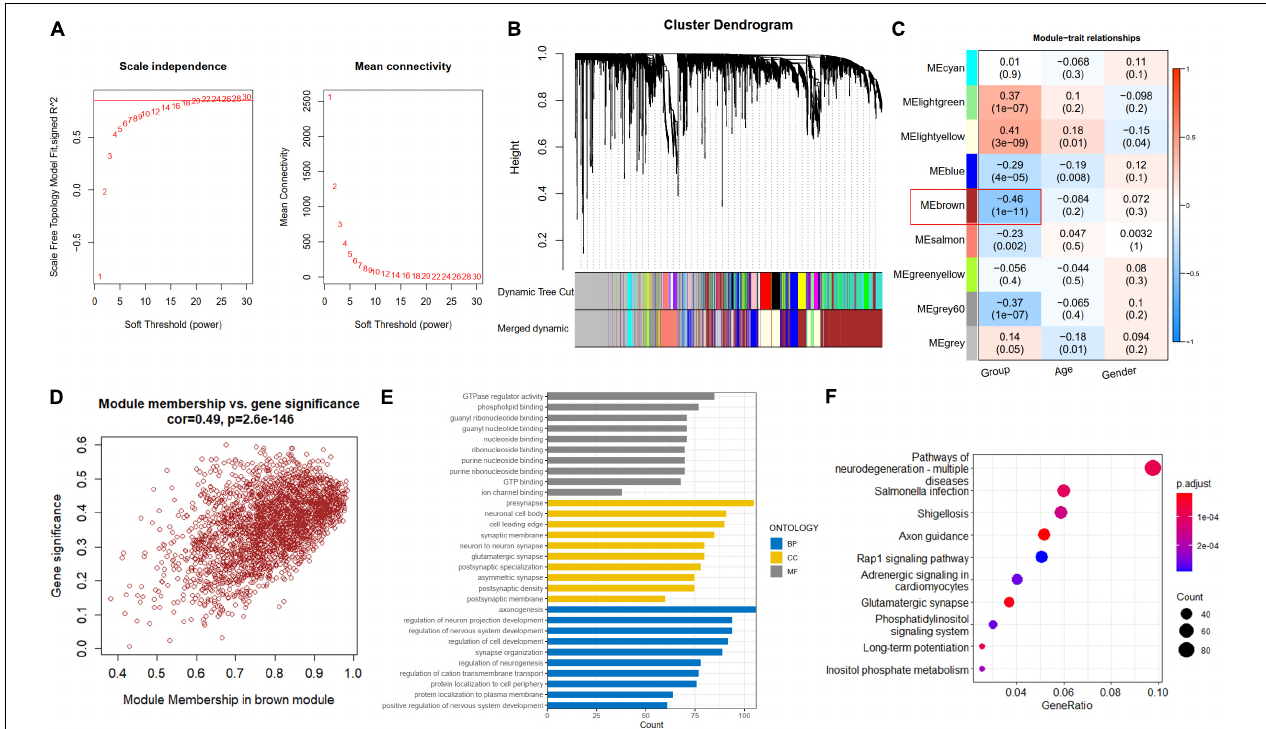
FIGURE 4 | Construction of co-expression modules. (A) Scale-free fitting index analysis and mean connectivity of soft threshold power from 1 to 30. (B) Clustering dendrograms. According to dynamic tree cutting, the genes were clustered into different modules through hierarchical clustering with the threshold of 0.25. Each color represents each module. (C) Correlation heatmap between module eigengenes and clinical traits. (D) Scatterplot of genes in the brown module. (E) GO of biological processes (BP), cellular component (CC), and molecular functions (MF) for brown module. (F) KEGG brown